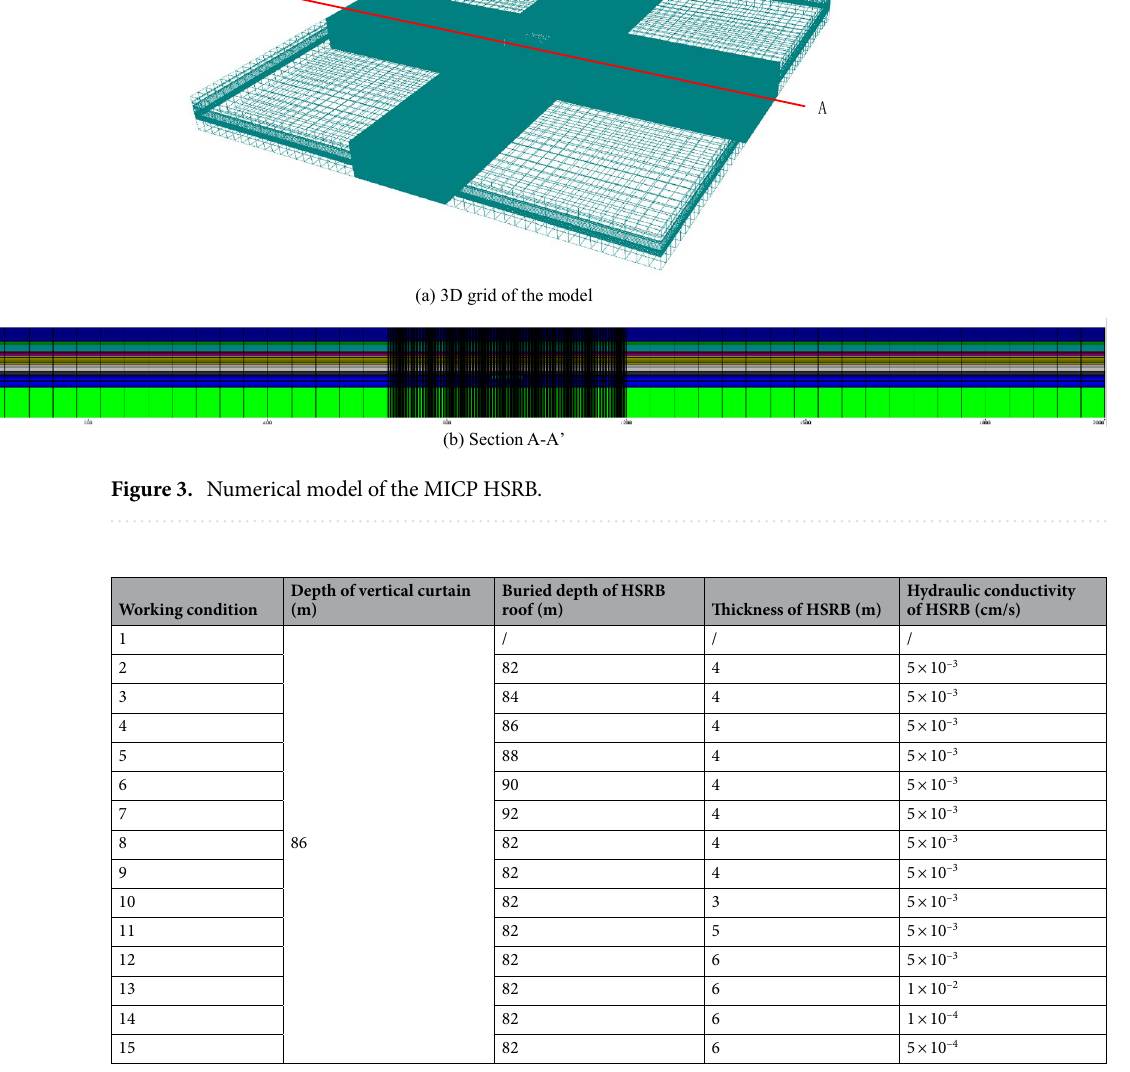
Working condition